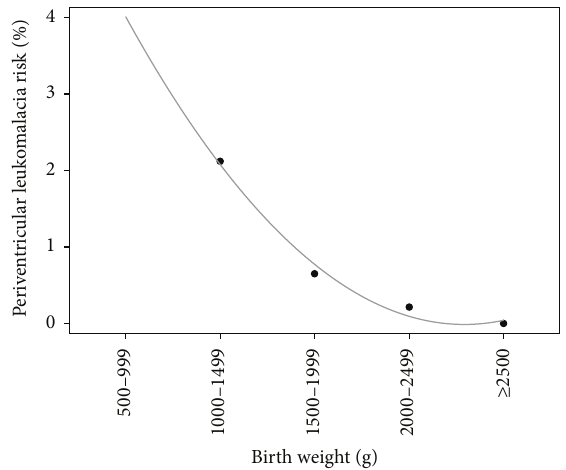
Figure 1: Exponential decrease in periventricular leukomalacia risk with increasing birth